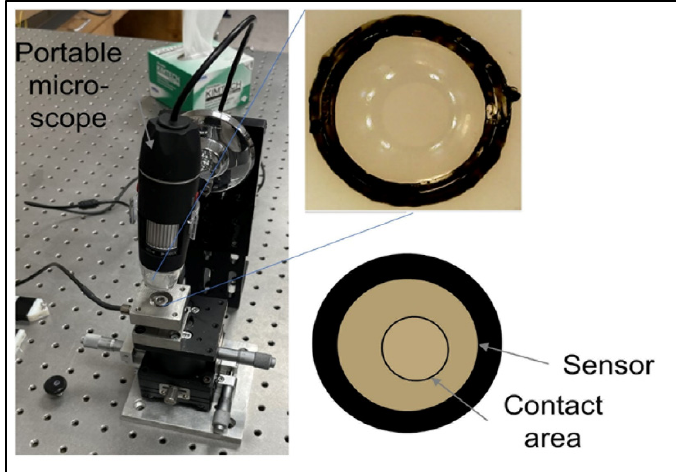
Figure 5. Portable microscope and sensor deformation area concept.